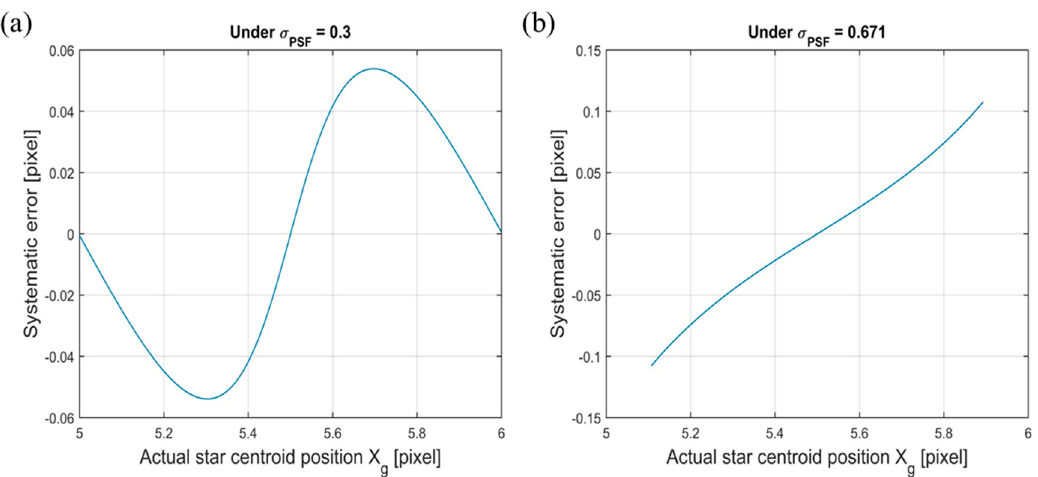
Figure 7. The relationship curve between σ ˆ x width σ PSF =